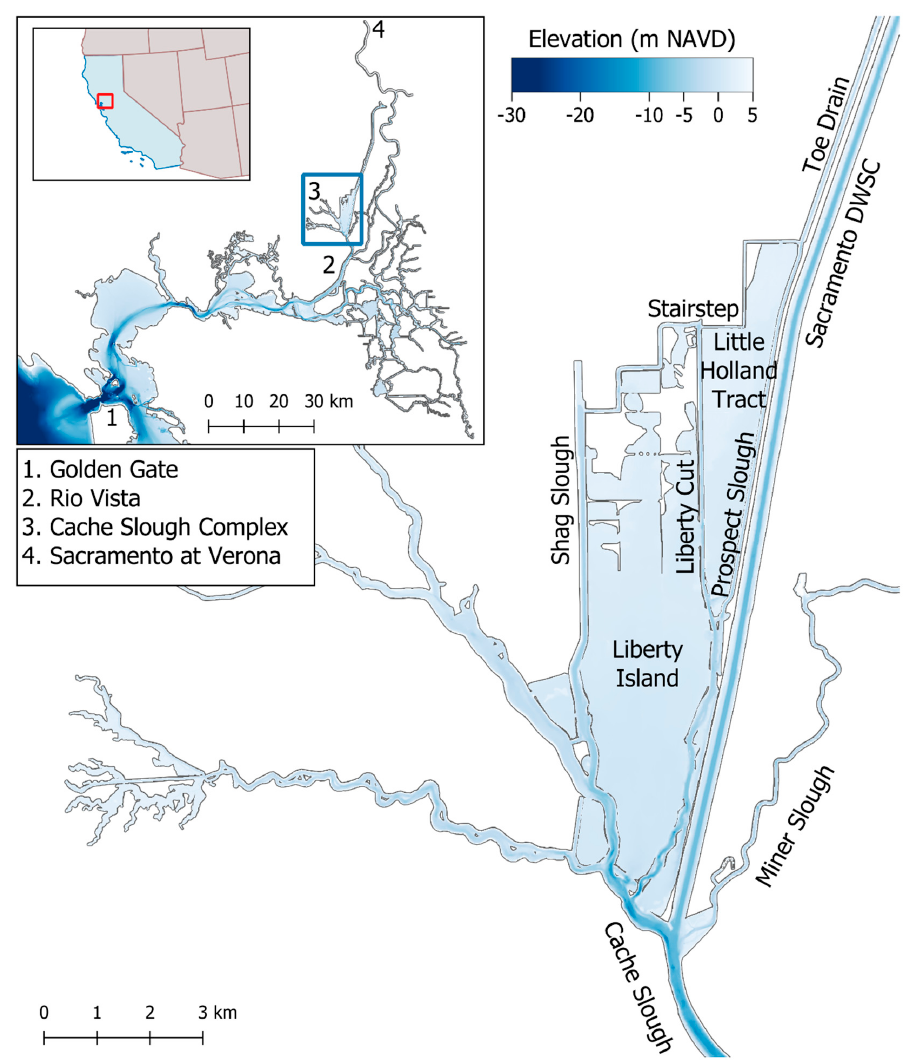
Figure 1. The bathymetry and names of channels in the Cache Slough Complex. The inset image in the upper left shows the northern portion of the San Francisco Estuary with relevant geographical labels. The location of the estuary in the state of California is shown in the small inset image in the upper left corner.